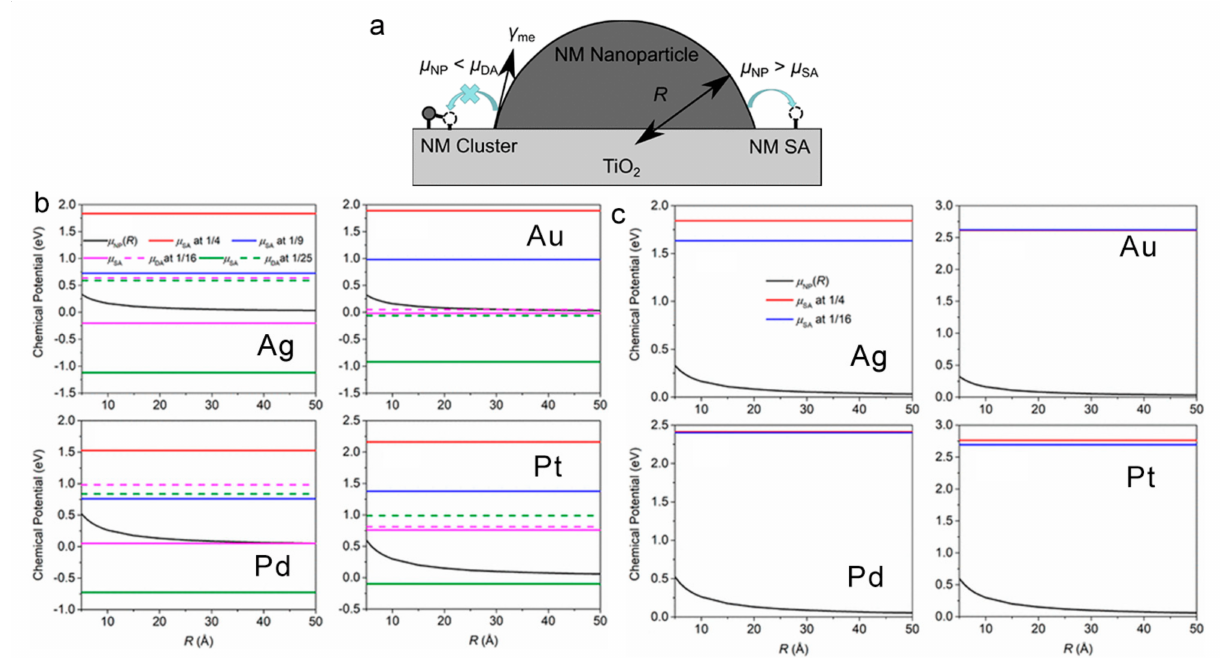
Figure 5. ( a ) Diagram of two constraint conditions on noble metal (NM) (NM = Ag, Au, Pd, and Pt) chemical potentials to prepare NM SAs on TiO 2 support, i.e., µ SA < µ NP < µ DA . ( b ) Chemical potentials of Ag, Au, Pd, and Pt SAs and DA clusters for the formation of NM-SA-(001) through compared with the chemical potentials of NM NPs as a function of their radii. ( c ) Chemical potentials of Ag, Au, Pd, and Pt SAs at two loading densities for the formation of NM-SA-(101) through comparing with the chemical potentials of NM NPs. Adopted with permission from Ref.